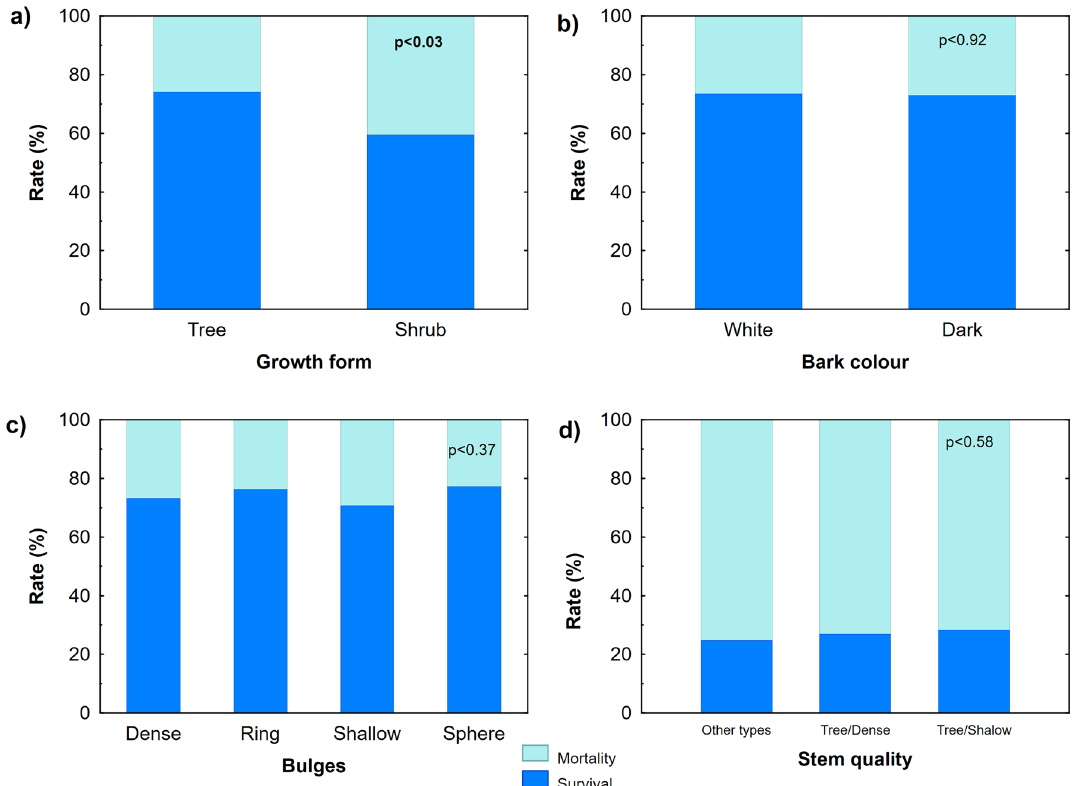
Figure 3. Survival and mortality rate of the curly birch progenies according to characteristics of parent trees displayed on x-axis: ( a ) growth form, ( b ) bark colour, ( c ) type of the bulges and ( d ) stem quality; the percentage of survival rate of progenies—dark blue, percentage of mortality rate—light